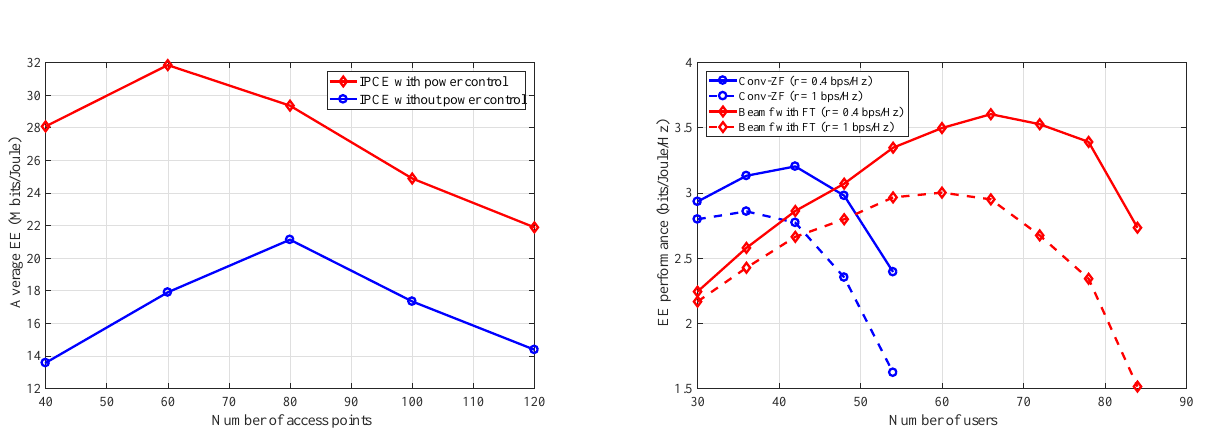
Figure 4. The average EE performance versus the number of Figure 5. EE performance of a three-cell network versus the access points. A wrapped around cell structure with 1 × 1 km 2 number of users per cell. Hexagonal cell structure with radius is setup with 16 single-antenna users randomly distributed. 1 km is setup with a centrally located BS equipped with The coefficient models of large-scale fading is as COST Hata 8 × 8 uniform planar array of antennas. Standard exponential model. The carrier frequency f GHz, bandwidth B = 20 correlation model is assumed to implement antenna spatial c = 1 . 9 MHz, τ = 200 , maximum transmit power of each AP and user correlation with correlation factor of 0 . 9 . Other simulation are 200 and 100 mW. The noise power at the receivers is parameters are as follows: carrier frequency = 2 GHz, Bandwidth = 10 MHz, BS transmission power = 46 dBm, path-loss model N 0 = 290 × κ × B × NF , where κ and NF are Boltzmann constants and noise figure at 9 dB. R dB (R in km), noise power density -174 128 . 1 + 37 . 6 log 10